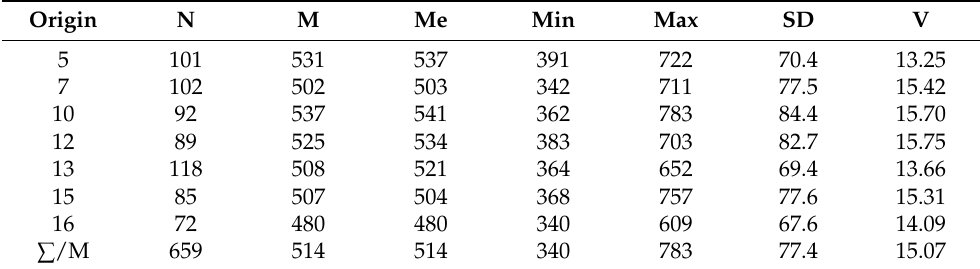
Table 1. Characteristics of wood density ( ρ ) (kg/m 3 ) of diverse genetic origins (N—Number of groups; M—Average; Me—Median; Min—Minimum; Max—Maximum; SD—Standard deviation; V—Coefficient of variation).